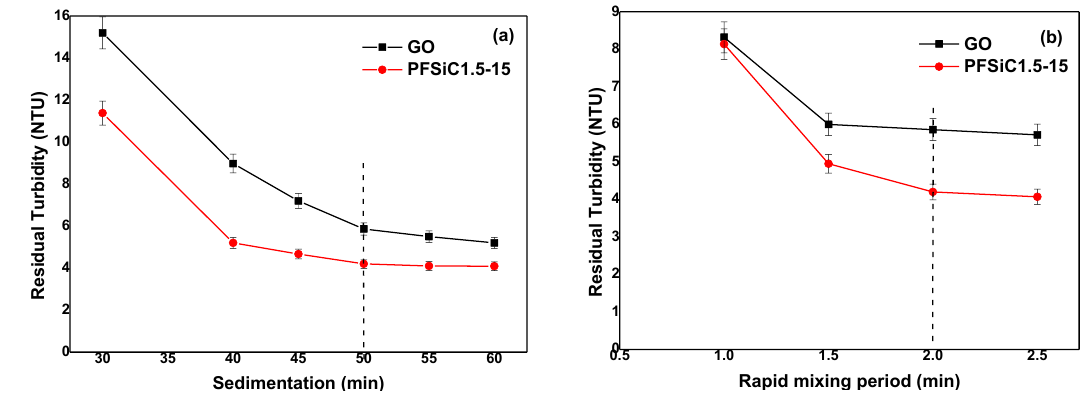
Figure 4. Determination of the optimum coagulation experimental conditions, comparing GO and PFSiC 1.5-15 materials, regarding the removal of turbidity (expressed as the residual turbidity, NTU); ( a ) by using different sedimentation times, and ( b ) by applying different rapid mixing period times.